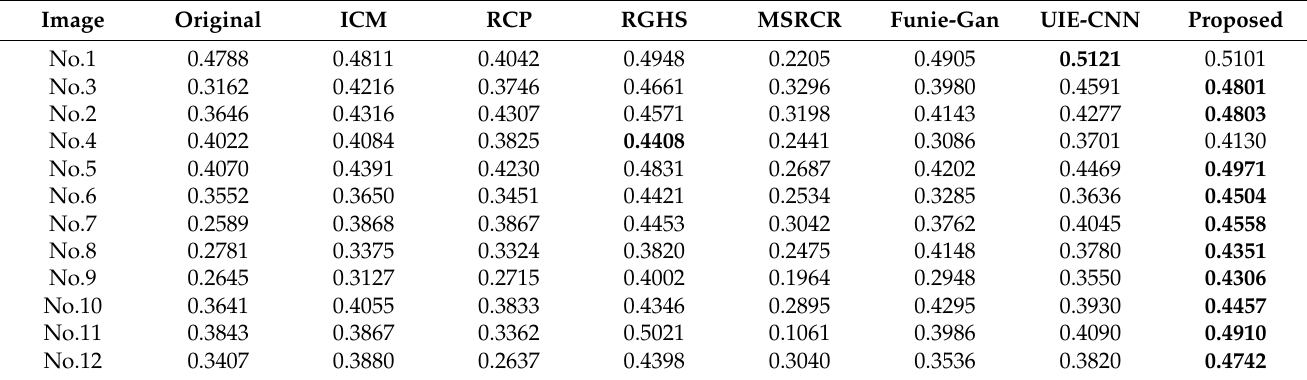
Table 6. Evaluation of processed images by UCIQE.